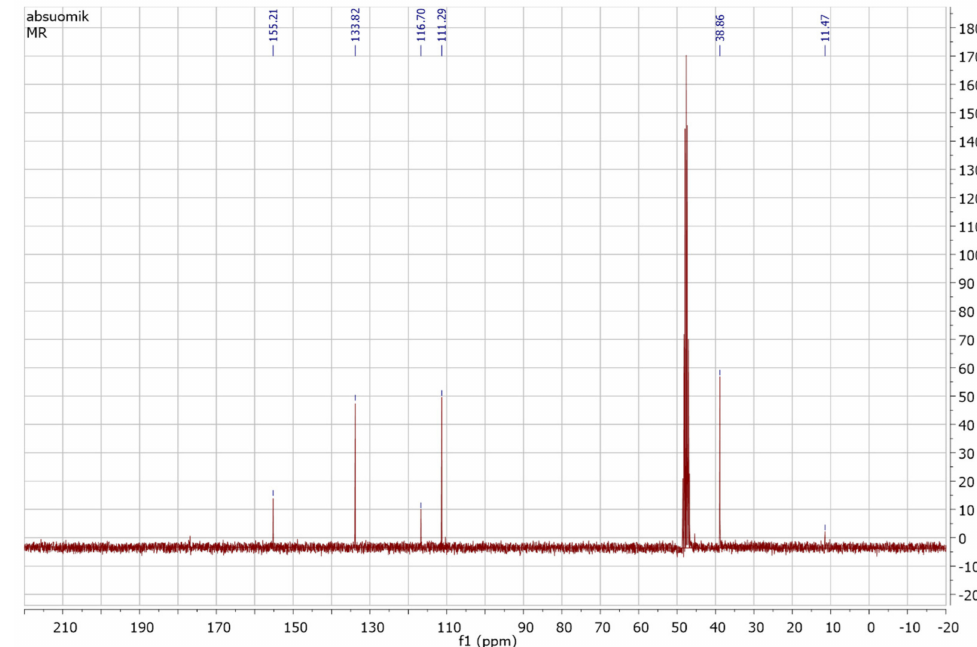
Figure 16. 13 C NMR of methyl red